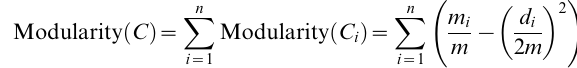
Figure S1 Normality check of the distributions of all pair-wise Pearson correlation coefficients by Kolmogorov-Smirnov (KS) test in (A) human, (B) mouse and (C) rat data. The red dotted lines represent the statistical significance cutoff for rejecting the normality assumption. Figure S2 The modular structure used in gene expression simulation. The network consists of 10 functional modules and 1 null module. Genes in each functional module are regulated by a latent regulator. Figure S3 2-D Hierarchical clustering results of 3 liver data sets. 6455 orthologous genes are on the horizontal axis, experiments are on the vertical axis. (A) for the human liver data; (B) for the mouse liver data; (C) for the rat liver data. The ordered sample annotations in the vertical axis and the ordered gene symbols in the horizontal axis for each figure are listed in Tablea S9, S10, S11, S12, S13, S14. Figure S4 Visualization of modules identified by spectral clustering on the connectivity matrix of conserved interactions among human, mouse and rat. Orthologous genes among the three species are on both rows and columns. A back dot represents a conserved interaction between the corresponding gene pairs. Colored squares along the diagonal indicate identified modules, which are numbered in decreasing order according their modularity (see main text Materials and Methods). Figure S5 Permutation test results for enrichment analyses. (A) Null distribution (blue bars) of the number of lipid associating genes by randomly select 1000 sets of 6455 genes, and the statistic calculated based on the 6455 orthologous genes (red line). (B) Null